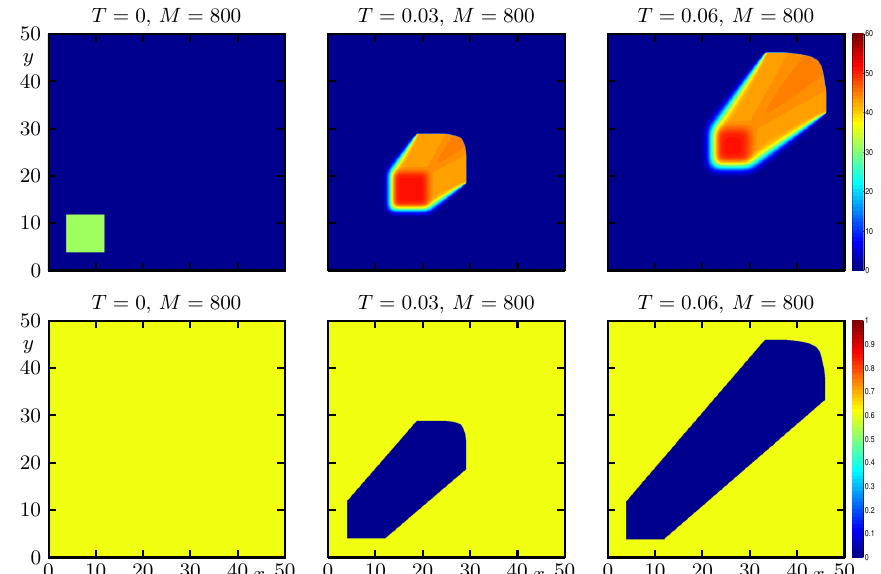
Figure 1. Example 1: Evolution of the dynamics of temperature ( top ) and fuel ( bottom ). Numerical approximation with S-LIMEX for ∆ x = ∆ y = 50/800.